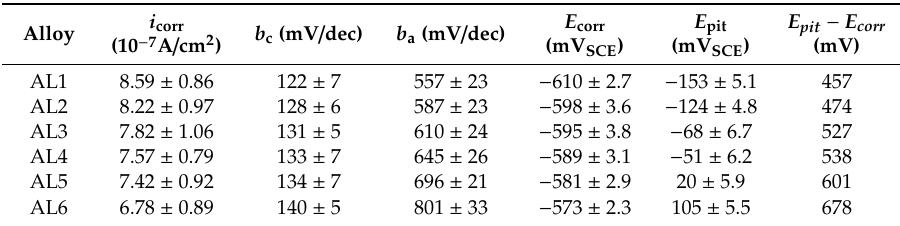
Table 2. Tafel extrapolation results of potentiodynamic polarization curves of the sintered alloys, the standard deviation comes from five valid parallel